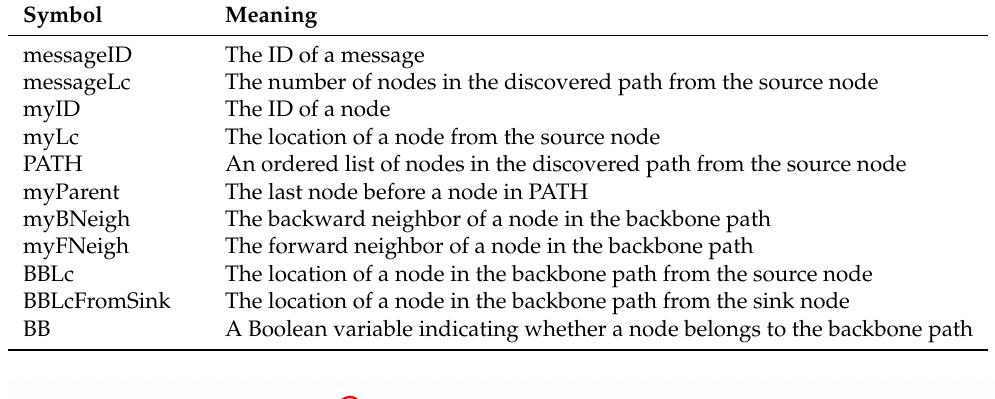
Table 1. Main notations used in the BD phase.